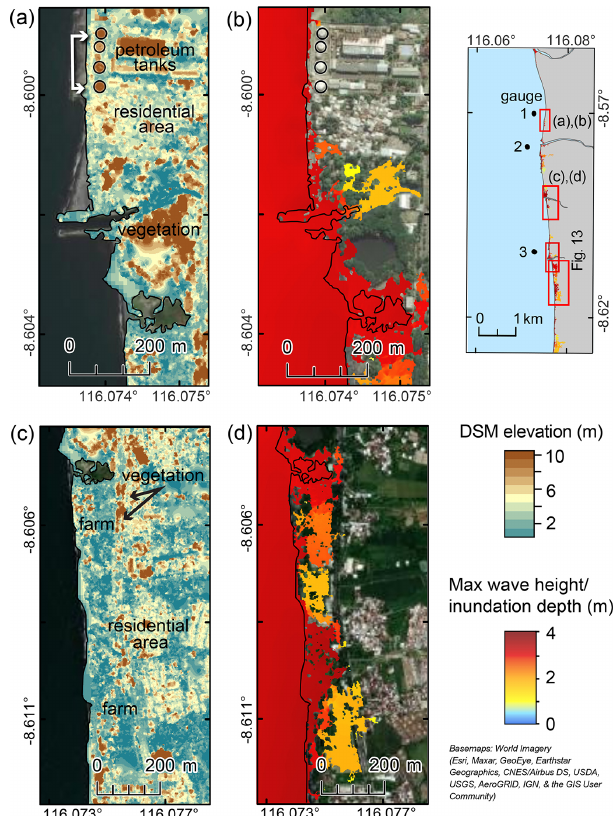
Figure 13. The DSM elevation and inundation on the southern coast of Mataram associated with 5m of coseismic slip on the Flores Thrust ramp (model A-5) overlain on World Imagery. (a, b) To the south of the industrial site (with petroleum tanks), the inundation depth is ≤ 1 . 5m and the inundation extent is ∼ 175m. (c, d) In the south, inundation is more extensive, likely because of the lower den- sity of structures and wider open area (beach and farmland). The in- undation depth is generally 2–3m, and the extent reaches ∼ 230m. Right image – location map of panels (a–d)